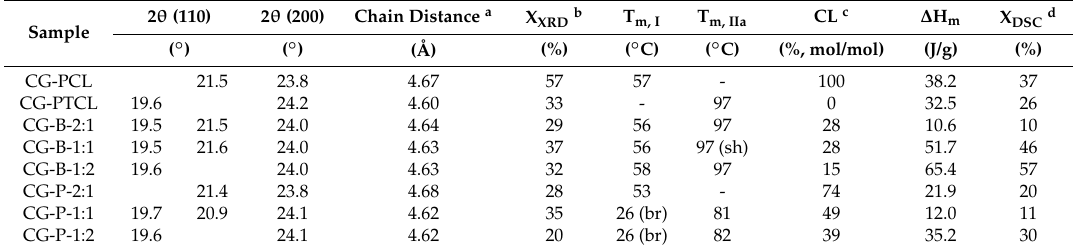
Table 4. Main XRD and DSC results of chitosan-grafted homo- and copolymers.